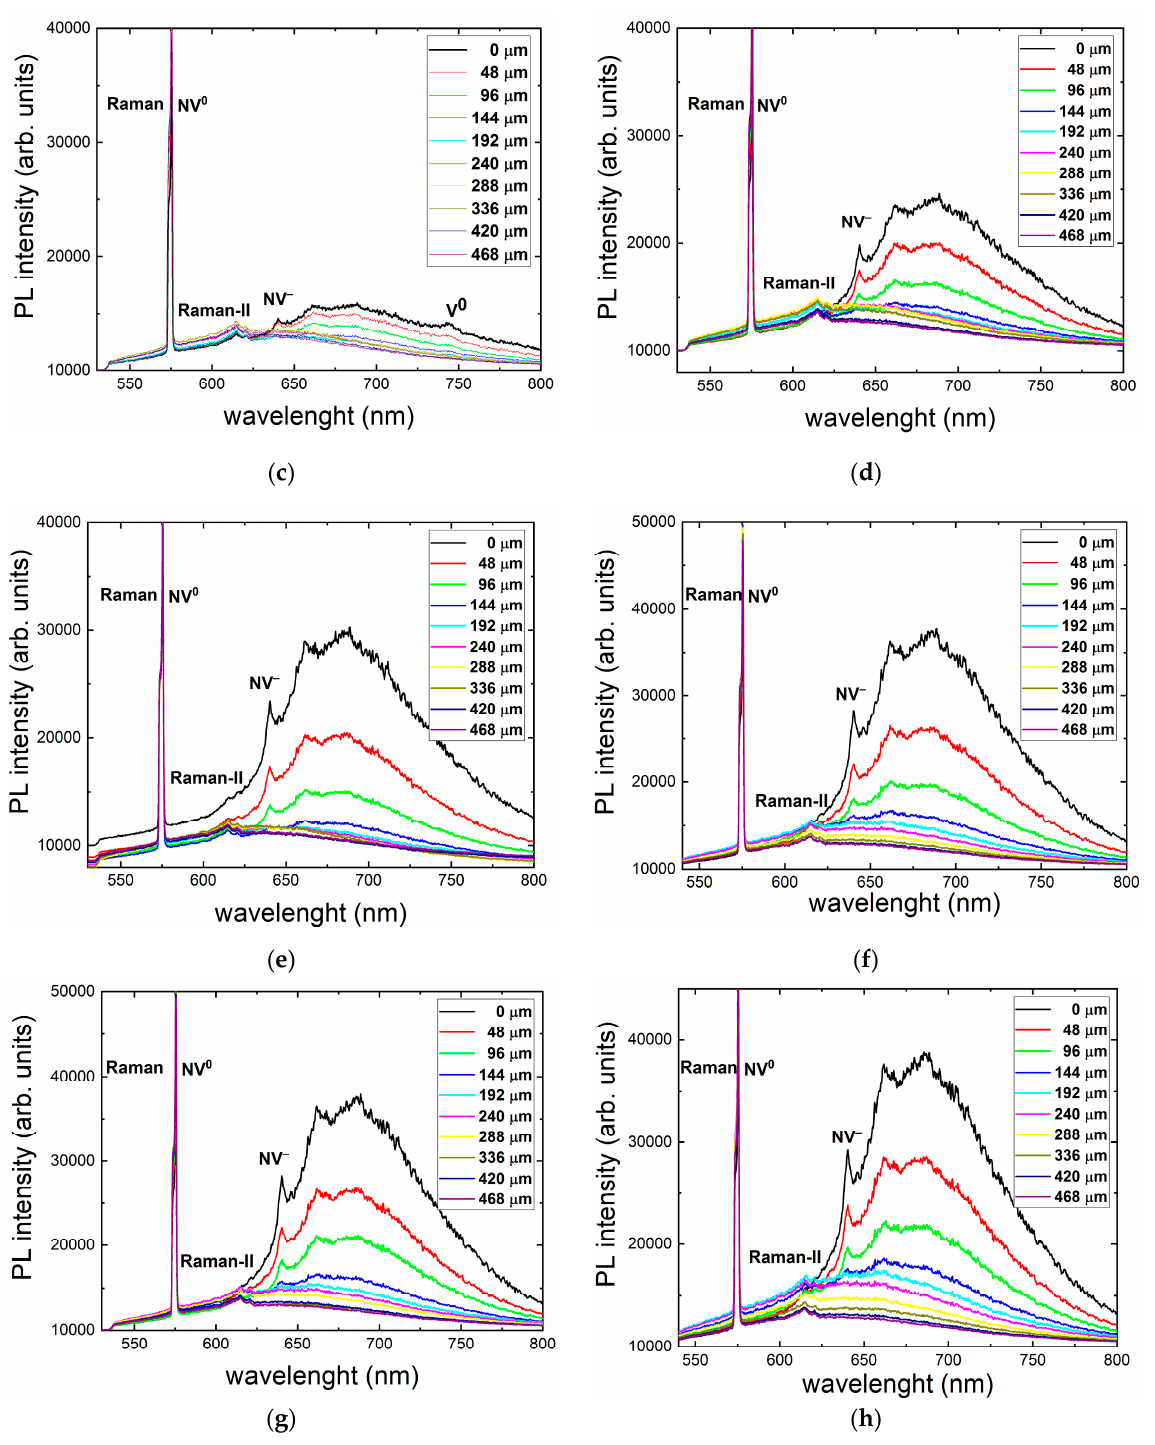
Figure 2. RT 532 nm excitation PL spectra at different depths in μ m inside the sample (frames) for an exposure time of 240 s (24 M pulses) and different incident 0.3 ps laser pulse energies ( μ J): 0/background ( a ), 0.4 ( b ), 0.6 ( c ), 0.8 ( d ), 1.0 ( e ), 1.2 ( f ), 1.4( g ), and 1.6 ( h ). Spectral assignment after [5].